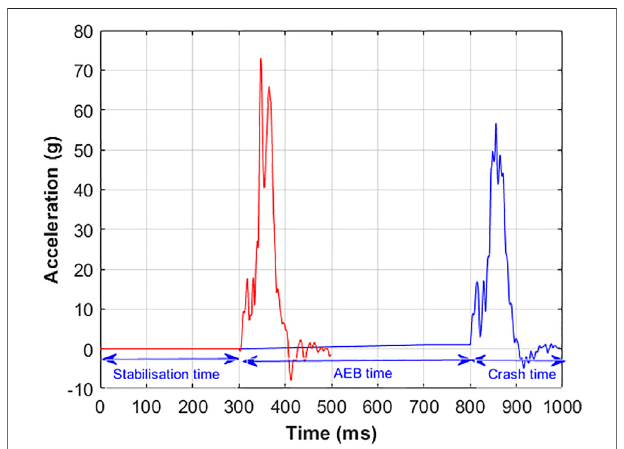
FIGURE 1 | Crash and AEB pulses. The red curve represents the crash pulse for the No_AEB+0N simulation. The blue curve represents the AEB and the crash pulse for the simulations with AEB and crash phases. The fi rst 300 ms in both curves represent the stabilization time.